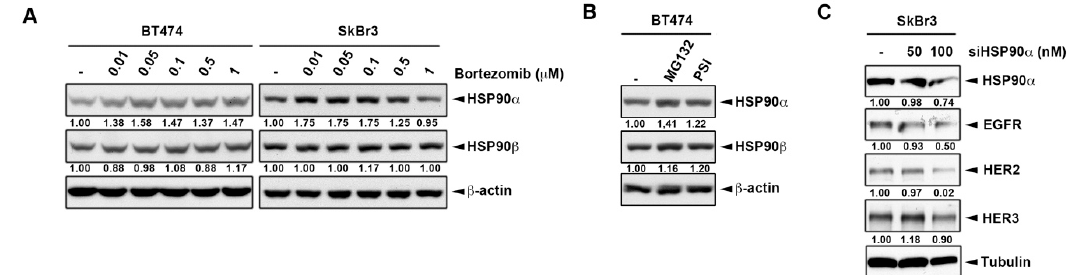
Figure 4. The involvement of heat shot protein 90 (HSP90) in the proteasome inhibitor induced ErbB family degradation. Whole cell lysates of BT474 and SkBr3 cells treated for three days with various concentrations of bortezomib ( A ), 10 µ M MG132, and 5 µ M PSI ( B ) were subjected to western blot analysis with indicated antibodies. SkBr3 cells were transfected with siHSP90 α and were then subjected to western blot analysis with indicated antibodies ( C ). The intensity of bands in western blot was quantitated using image J and β -actin / Tubulin was used as the loading control for normalization.